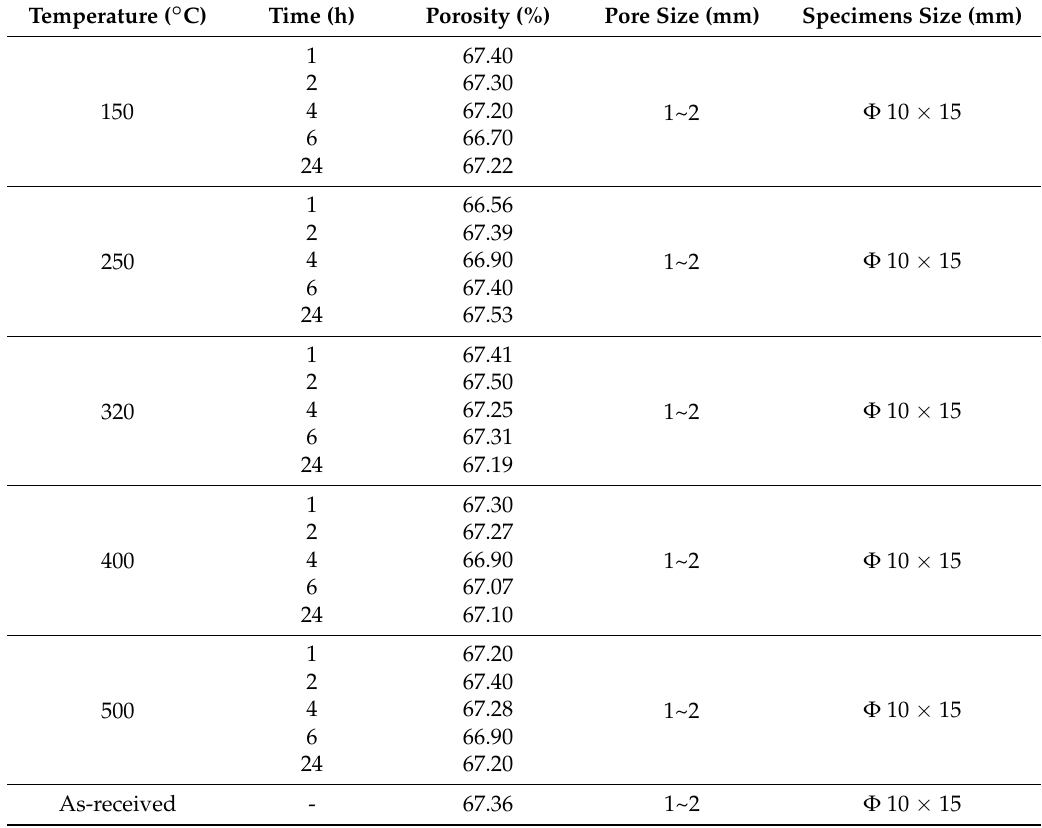
Table 3. Thermal treatment parameters and physical properties of the